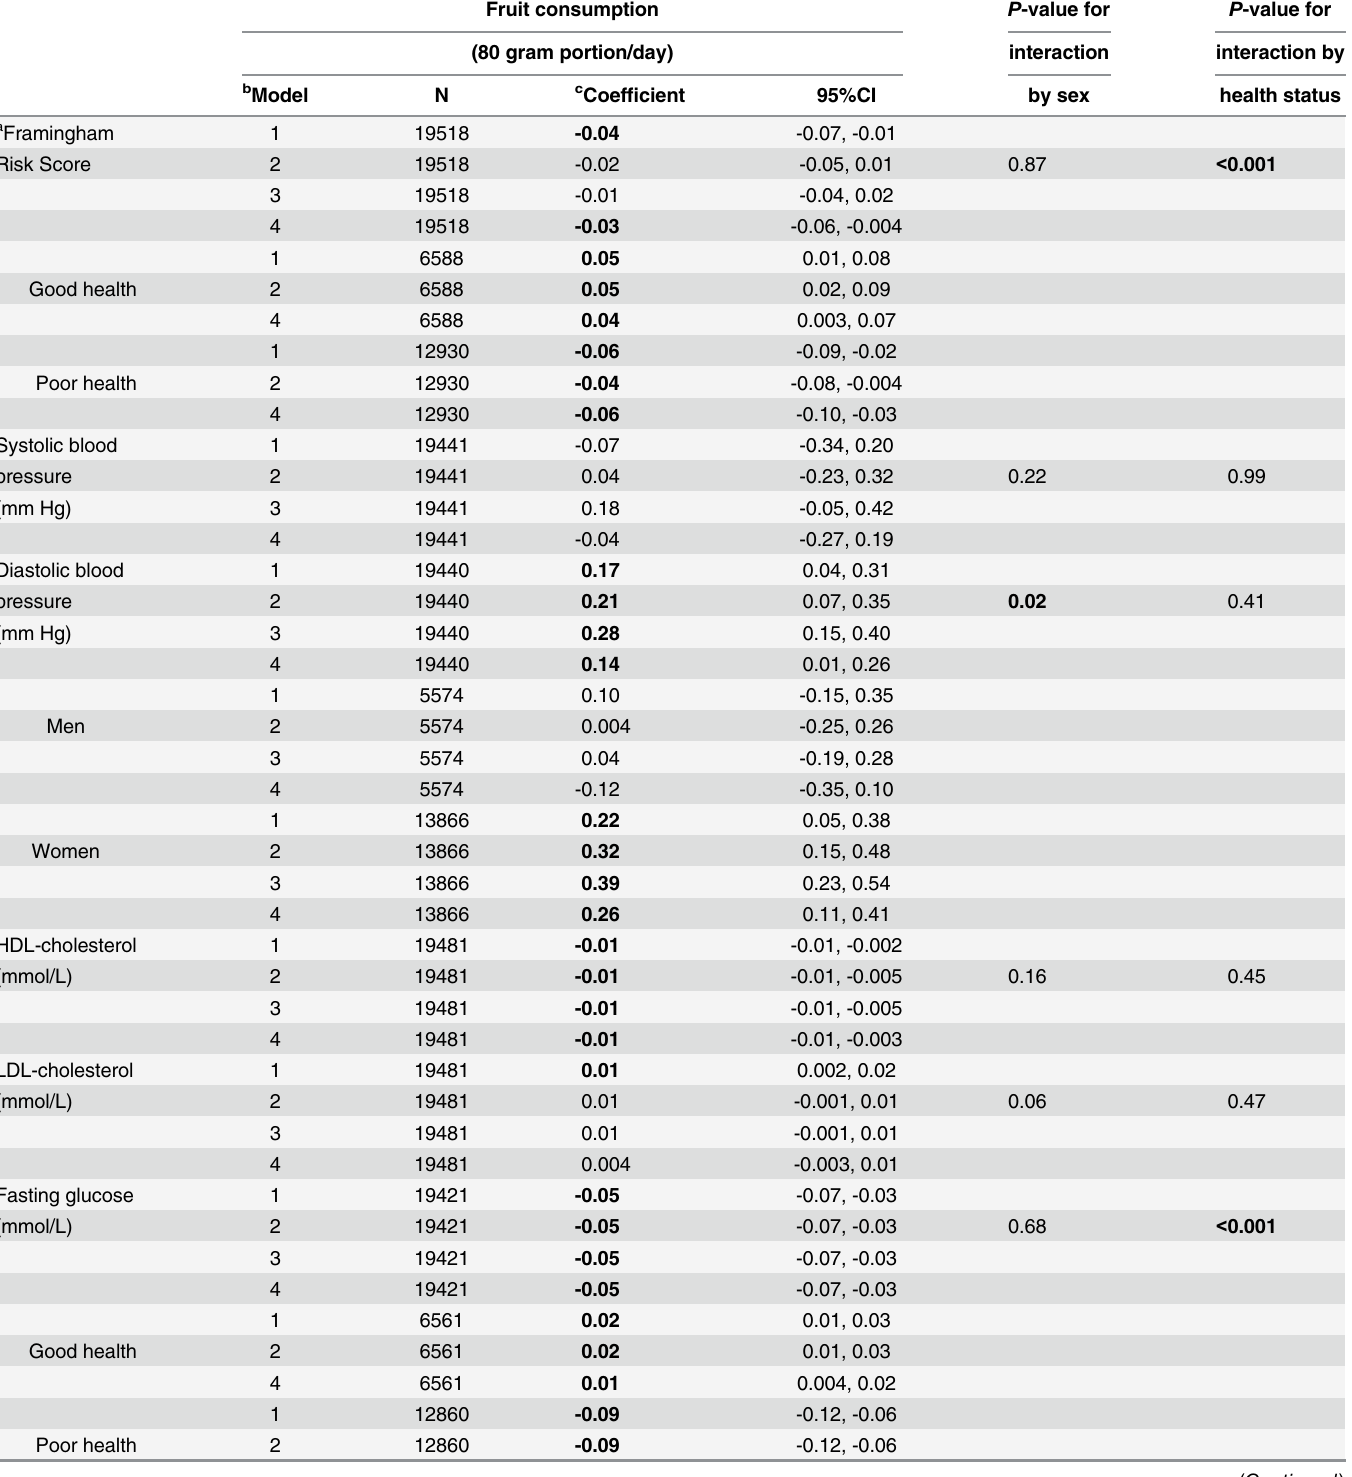
Table 2. Adjusted Associations of Fruit Consumption with Framingham Risk Score and CVD Risk Factors after Multiple Imputation in Older Chi- nese in Phases 1 and 2 of the Guangzhou Biobank Cohort Study, 2003 – 2006. Fruit consumption P -value for P -value for (80 gram portion/day) interaction interaction